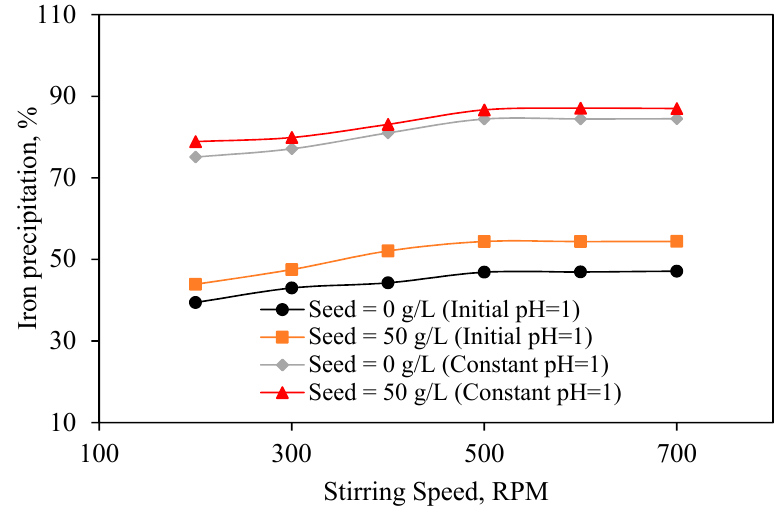
Figure 9. Effect of stirring speed on iron precipitation (Process time of 300 min). (Constant pH = 1, [Na 2 SO 4 ] = 2 g/L, Temperature = 90 °C).